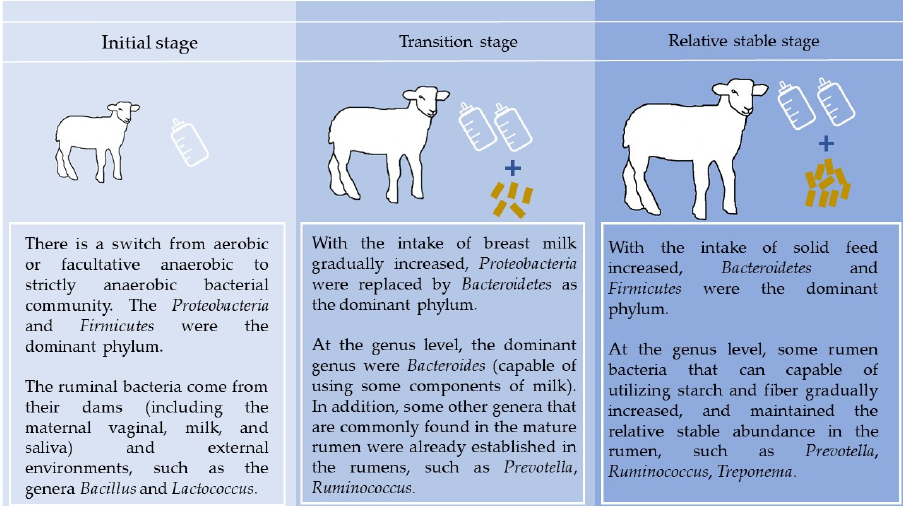
lambs is also divided into three consecutive stages, namely 0–3, 10–20, and 20–60 days of age [9]. The Proteobacteria were replaced by Bacteroidetes as the dominant phylum at the initial colonization process of lambs, the genera Bacteroides was the main transitional taxa, and Prevotella were the main mature taxa [10,17]. However, there are still some differences in the colonization process of rumen microbes between calves and goat kids. Li et al. [10] and Zhang et al. [17] reported that the colonization process of the rumen bacteria in goat kids can be divided into three stages: the initial phase (0–14 days after birth), transition phase (14–28 days after birth), and relative stable phase (28–56 days after birth). During the initial phase, the genera Bacillus and Lactococcus were predominant in newborns. As the dominant maternal vaginal flora, the genera Bacillus and Lactococcus were delivered to the next generation and play a key role in host-immune regulation [19]. However, the colonization of Bacillus and Lactococcus was transient and it was rapidly replaced by the genera known to readily degrade milk nutrients (e.g., Bacteroides ). During the transition phase, the genera Bacteroides , Bacteroidales BS11 gut group , Alloprevotella , and Ruminococcaceae NK4A214 group were the main transitional taxa. During the relatively stable phase, the genera capable of degrading plant fibers were increased, such as Prevotella , Treponema , Ruminococcus , and the unclassified Prevotellaceae were the main mature taxa. Taken together, the above studies suggest that changes in age may be the main factor affecting the microbial colonization of the rumen. Keeping in view the above studies, the early rumen microbial establishment process can be divided into three stages (Figure 1): (1) In the initial stage, there is a switch from aerobic or facultative anaerobic to strictly anaerobic bacterial community [20]. At the phylum level, the Proteobacteria and Firmicutes were the dominant phyla [10,18]. The ruminal bacteria come from their dams (including the maternal vaginal, milk, and saliva) and external environments [21], such as the genera Bacillus and Lactococcus . (2) In the transition stage, with the intake of breast milk gradually increased, Proteobacteria were replaced by Bacteroidetes as the dominant phylum. At the genus level, Bacteroides , capable of using some components of milk, were the dominant genus. In addition, some rumen bacteria that are commonly found in the mature rumen were already established in the rumens, such as Prevotella and Ruminococcus [17,22]. (3) In the relatively stable stage, with the intake of solid feed increased, Bacteroidetes and Firmicutes were the dominant phylum. At the genus level, some rumen bacteria that can be capable of utilizing starch and fiber gradually increased, and maintained the relative stable abundance in the rumen, such as Prevotella , Ruminococcus , and Treponema [9,10,18].